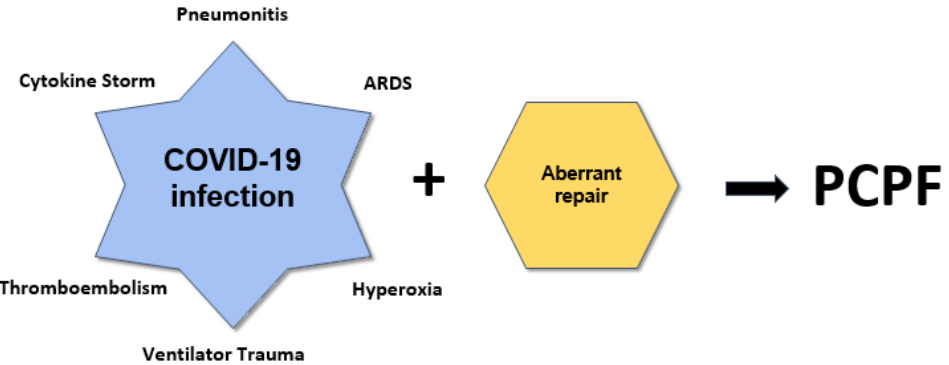
Figure 1. Injury → Inflammatory response → Repair → Fibrosis.